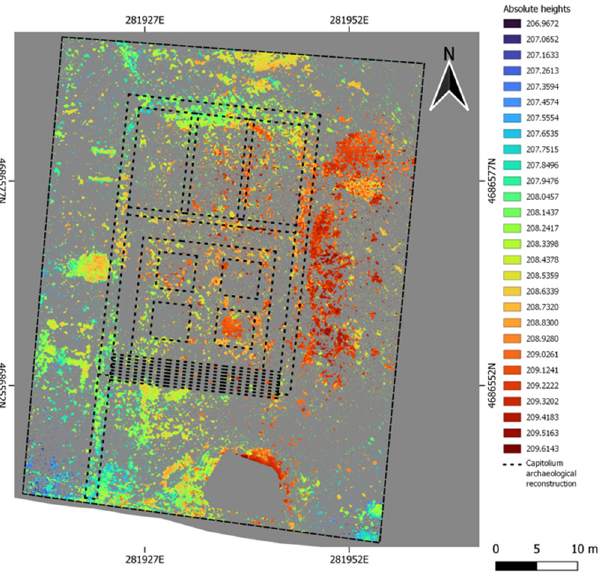
Figure 9. Hypothetical plan of the “ Capitolium ” (in black) on the base of the “buried feature elevation map” (image by M. Serpetti).